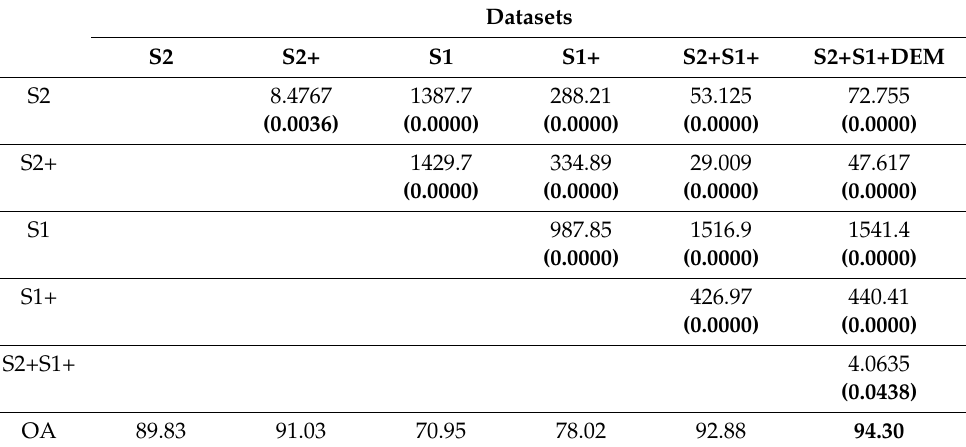
Table 5. McNemar’s chi-squared test score (z) of data pairs. Values in parenthesis represent p -value. Data pairs that show statistically significant difference ( p ≤ 0.05) and the best overall accuracy (OA) are in bold.